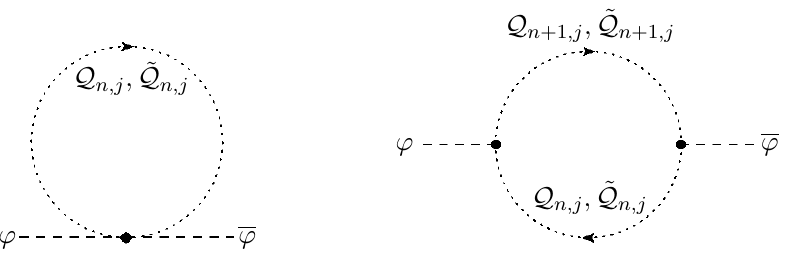
Figure 3. Bosonic contributions to the Wilson line mass with (cid:13)ux.